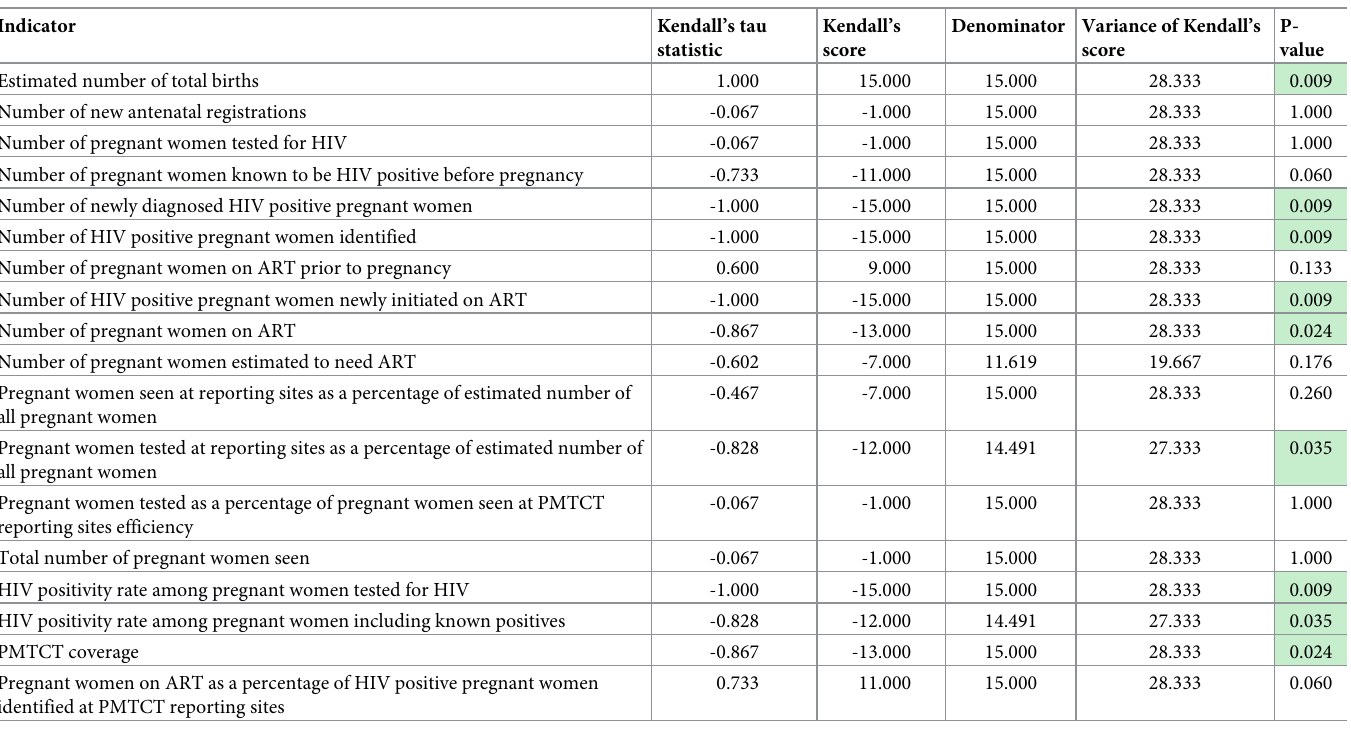
Table 2. Mann-Kendall trend test statistics for PMTCT